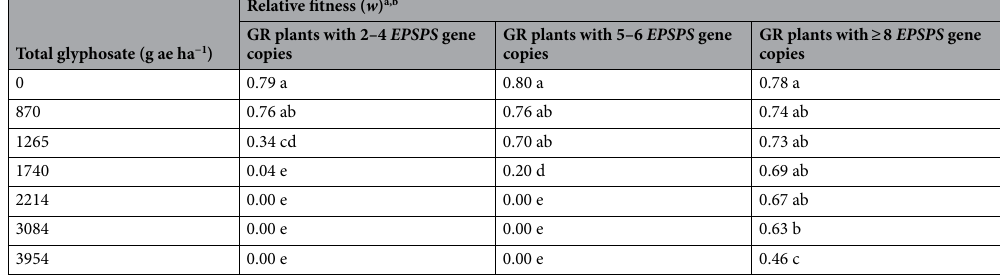
tions of the maximum-labeled use rate of glyphosate (total of 3954 g ae ha −1 of glyphosate) in a GR sugar beet field. However, seed production of GR B. scoparia plants with 2–4 (low-level resistance) and 5–6 (moderate level resistance) EPSPS gene copies that emerge before the 2-leaf stage of sugar beet can be prevented with three sequential applications of glyphosate, with a total rate of 3084 g ae ha −1 . However, any survivors may increase the risk of GR progenies with higher levels of evolved resistance in the population. Other reproductive traits. For GR B. scoparia plants, the variation in EPSPS gene copy number (those with 2–4, 5–6, ≥ 8 EPSPS gene copies), total glyphosate rate (applied as single or sequential applications), and their interac- tions did not influence time to 50% flowering, time to seed set, pollen viability, 1000-seed weight, seed viability, and seedling radicle length (Table 2). These results indicate that seedling vigor of progenies from GR B. scoparia plants (2 to ≥ 8 EPSPS gene copies) will be comparable regardless of the glyphosate rate, and if let to set seed can potentially build up resistance very rapidly due to pollen-mediated gene flow. The range for time to 50% flower- ing was 39–41 days after transplanting, time to set seeds was 57–60 days after transplanting, pollen viability was 82–86%, 1000-seed weight was 0.59–0.61 g, seed viability was 94–99%, and radicle length was 0.53–0.54 cm across EPSPS gene copy numbers and total glyphosate rates.